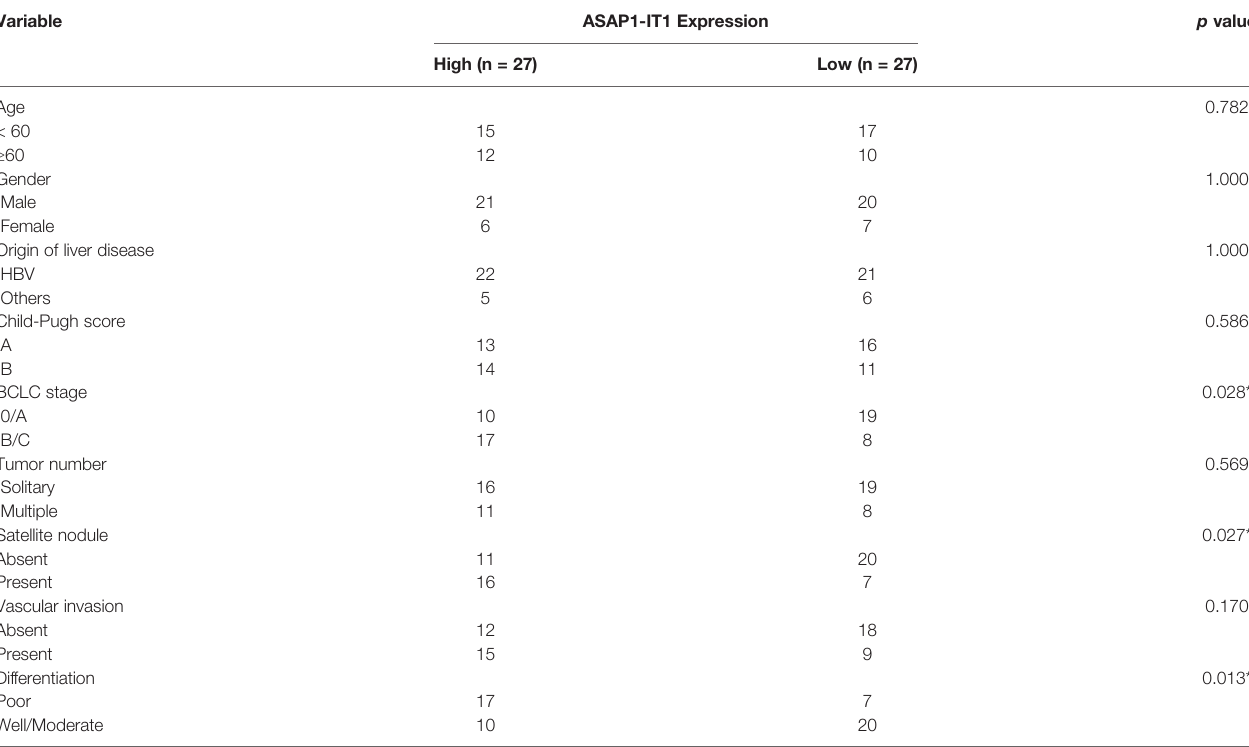
TABLE 1 | The association between ASAP1-IT1 expression and clinicopathological features of HCC patients. Variable